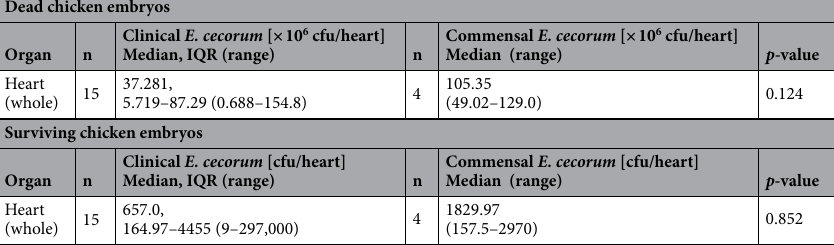
Table 4. Bacterial loads in the whole heart [cfu/heart] of dead (13 di, 2 dpi) and surviving (18 di, 7 dpi) SPF chicken embryos inoculated with clinical or commensal Enterococcus cecorum strains (at a dose of